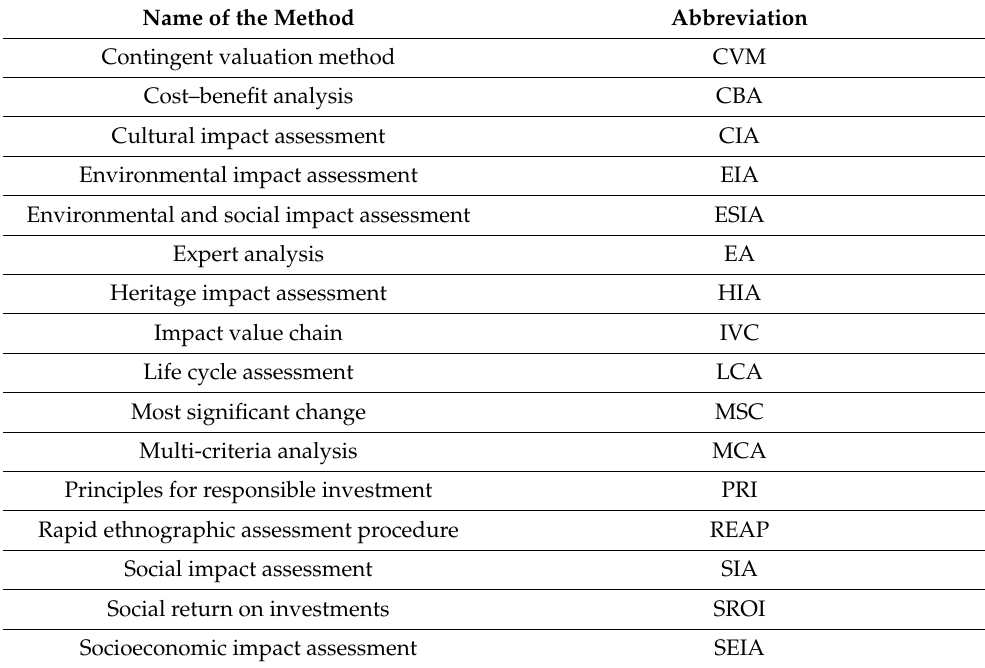
Table 1. Names and abbreviations of mostly used social assessment methods. Name of the